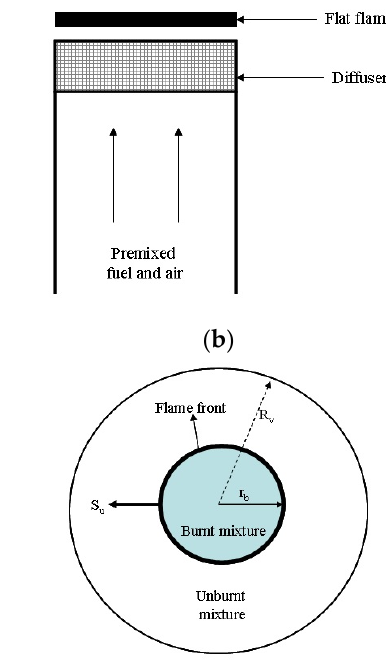
Table 2. Comparison of experimental methods for determining the laminar burning velocity described in the present work.